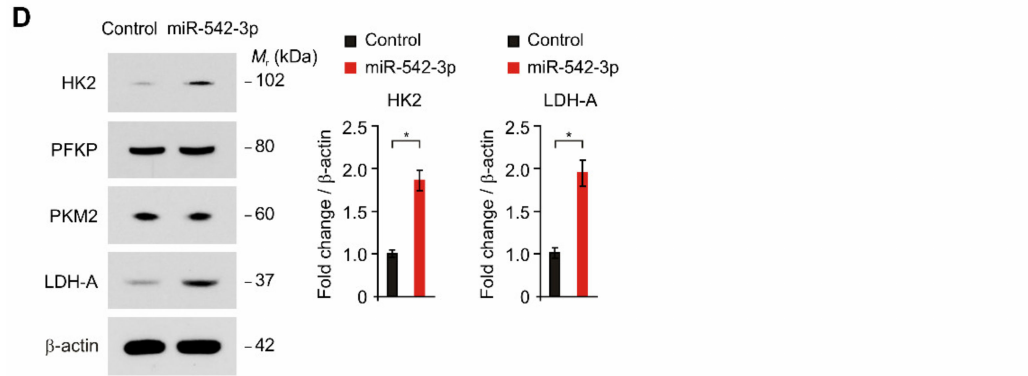
Figure 2. miR-542-3p regulates the HK2-mediated high glycolytic phenotype in human glioma cells. ( A ) The ECAR levels in response to glucose, oligomycin, and 2DG (left) and quantification of ECAR levels (right) in microRNA hairpin inhibitor negative control treated (Control) and miR-542-3p knockdown (miR-542-3p KO) human glioma U87MG cells. Representative data are determined from three independent experiments. Data are mean ± SEM. ** p < 0.01; * p < 0.05 by two-tailed Student’s t -test. ( B ) Representative immunoblot analysis for HK2, PFKP, PKM2, and LDH-A protein levels (left) and quantification for HK2 and LDH-A protein levels (right) in microRNA hairpin inhibitor negative control treated (Control) and miR-542-3p knockdown (miR-542-3p KO) human glioma U87MG cells. In immunoblots, the levels of β -actin were used as loading control. Representative data are determined from three independent experiments. Data are mean ± SD. * p < 0.05 by the two-tailed Student’s t -test. ( C ) The ECAR levels in response to glucose, oligomycin, and 2DG (left) and quantification of ECAR levels (right) in microRNA mimic negative control treated (Control) and miR-542-3p over-expressed (miR-542-3p) human glioma U87MG cells. Representative data are determined from three independent experiments. Data are mean ± SEM. ** p < 0.01 by two-tailed Student’s t -test. ( D ) Representative immunoblot analysis for HK2, PFKP, PKM2, and LDH-A protein levels (left) and quantification for HK2 and LDH-A protein levels (right) in microRNA mimic negative control treated (Control) and miR-542-3p over-expressed (miR-542-3p) human glioma U87MG cells. In immunoblots, the levels of β -actin were used as loading control. Representative data are determined from three independent experiments. Data are mean ± SD. * p < 0.05 by the two-tailed Student’s t